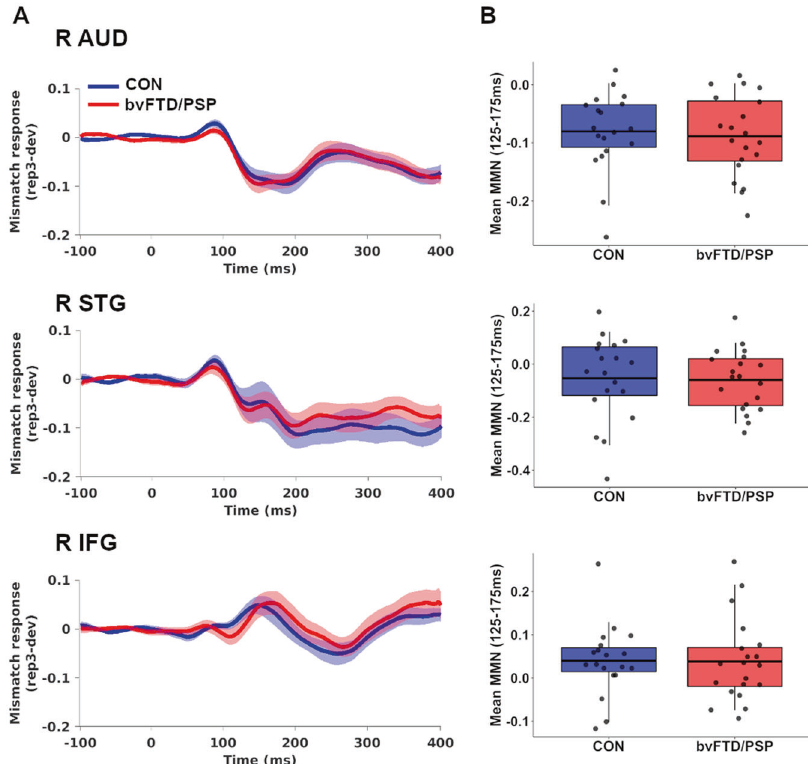
Fig. 2 Mismatch responses of source regions across controls and bvFTD/PSP patients on placebo. A Group average mismatch responses across peri-stimulus window for controls (blue line) and bvFTD/PSP (red), derived from each individual by the difference of the rep3 and dev waveforms. Thick lines and shading represent group average and its standard error at each time-point, respectively. B Mean MMN responses (average of mismatch waveform between 125 and 175 ms) in controls and patients, with middle line indicating the group mean. Boxes represent interquartile range of 25% and 75% percentile, with whiskers indicating 95% probability density. R IFG right inferior frontal gyrus, R STG right superior temporal gyrus, R AUD right auditory cortex, bvFTD behavioural variant frontotemporal dementia, PSP progressive supranuclear